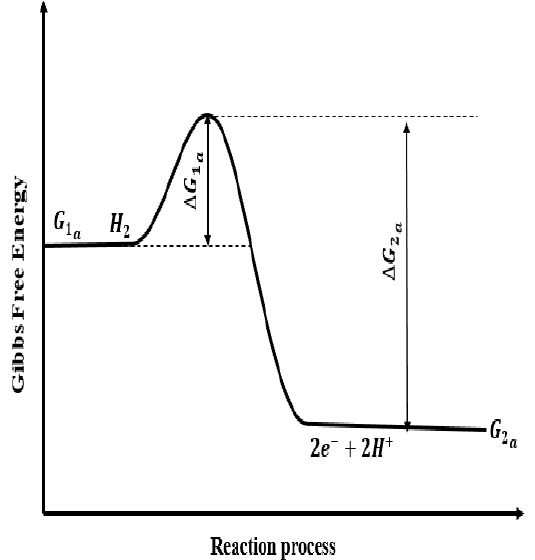
Figure 1. Energy change of reaction process in anode electrode. G 1 a —Gibbs free energy of anode reactants; ∆ G 1 a —activation energy of forward reaction in anode; G 2 a —Gibbs free energy of anode products; ∆ G 2 a —activation energy of reverse reaction in